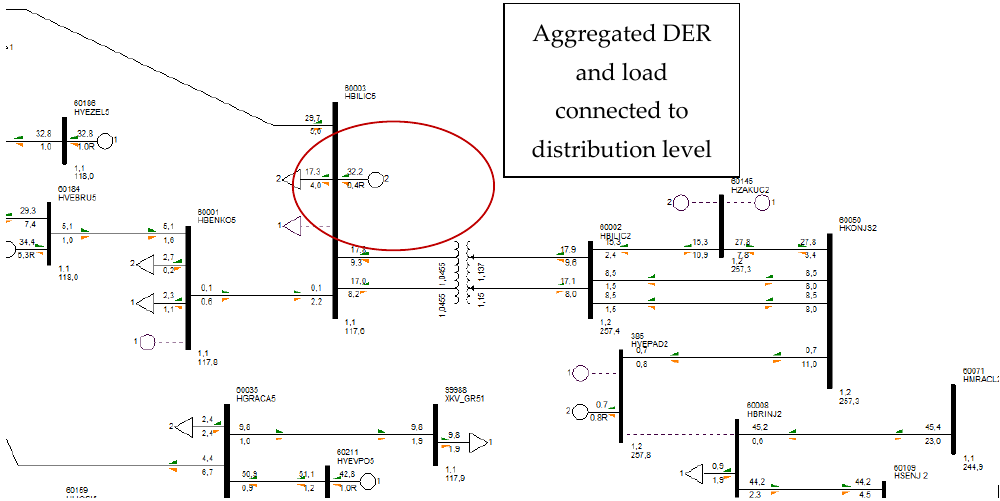
Figure 8. Calculated power flow and voltages of analyzed power transmission system–aggregated DER and load–upstream load flow.